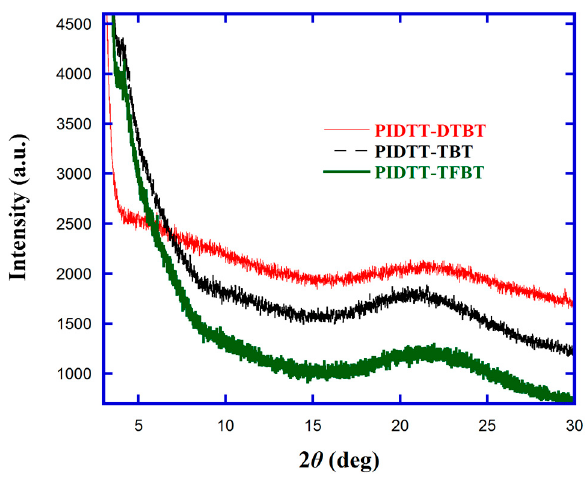
Figure 4. X-ray patterns of PIDTT-DTBT, PIDTT-TBT, and PIDTT-TFBT.